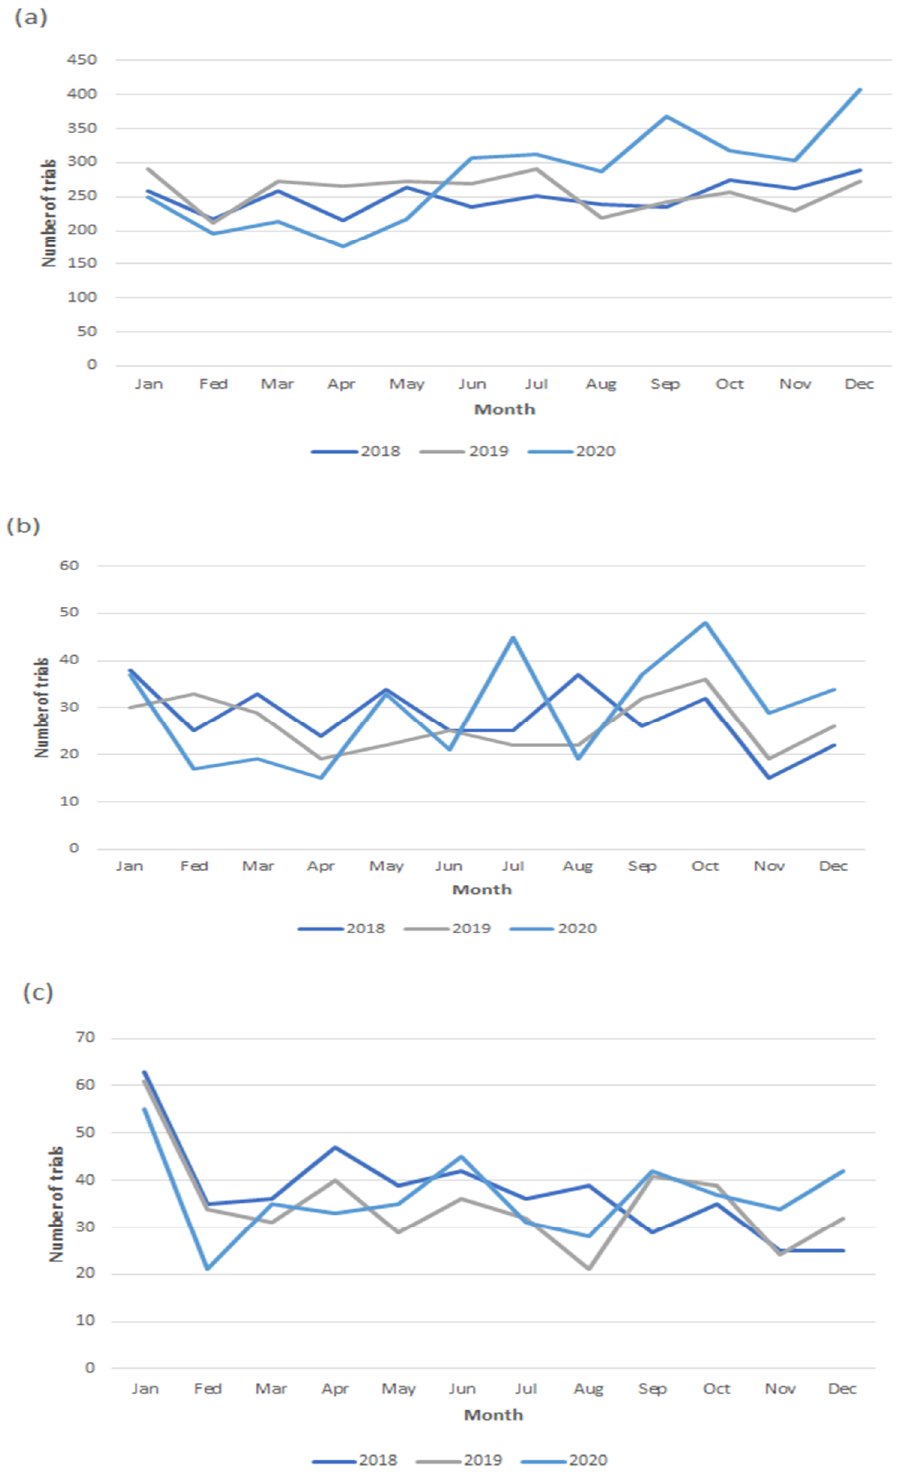
Figure 5. Monthly trends in the commencement of new oncology trials according to type of interventions from 2018 to 2020. ( a ) Drug; ( b ) device; and ( c ) procedure.